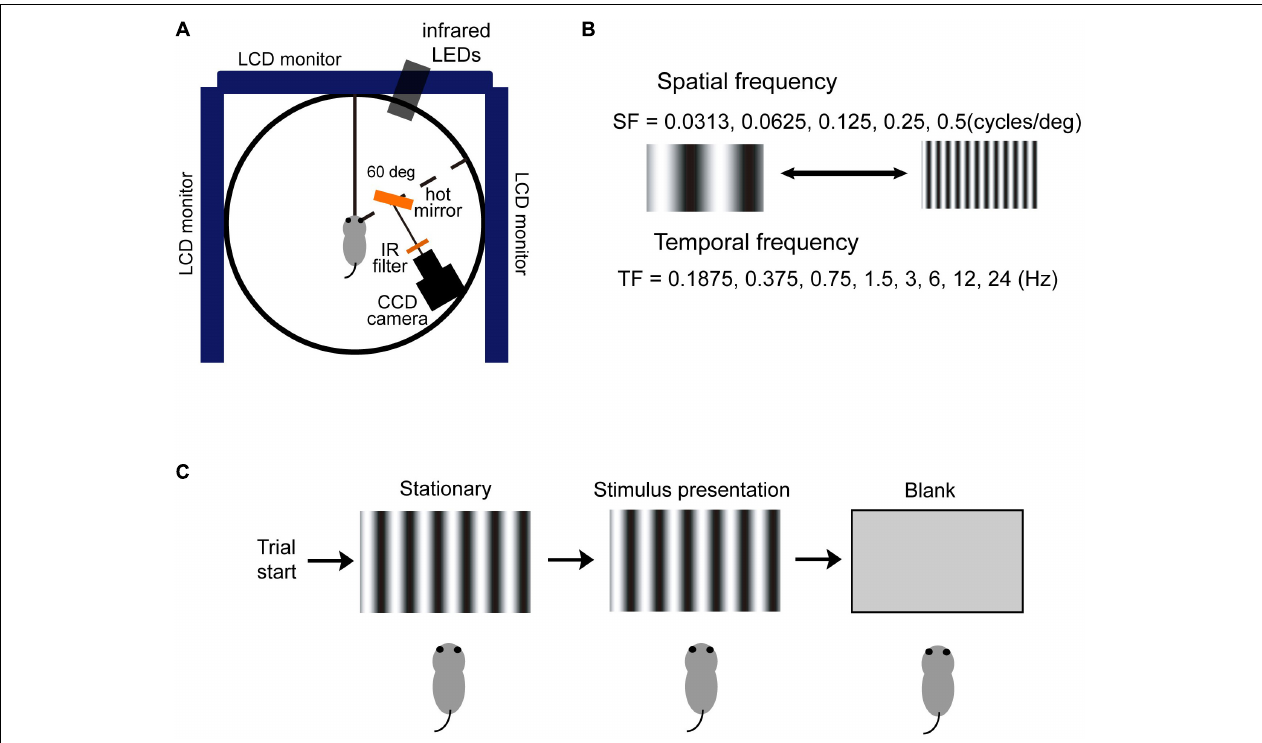
FIGURE 4 | A schematic diagram of the stimuli used for OKR recordings. (A) The right eye of each mouse was illuminated by infrared (IR) LEDs and monitored using a CCD camera. Data were analyzed on a computer using an image processing software (Geteye). (B) The SFs of the visual stimulus were 0.0313, 0.0625, 0.125, 0.25, and 0.5 cycles/deg. The motion of the visual stimulus was defined by the TF, which was 0.1875, 0.375, 0.75, 1.5, 3, 6, 12, or 24 Hz. (C) Scheme of the experimental procedure. A stationary visual pattern was presented and then moved T-N direction (temporal–nasal motion for the right eye) or N-T direction (nasal–temporal motion for the right eye) at a constant speed. After a defined period, the pattern was